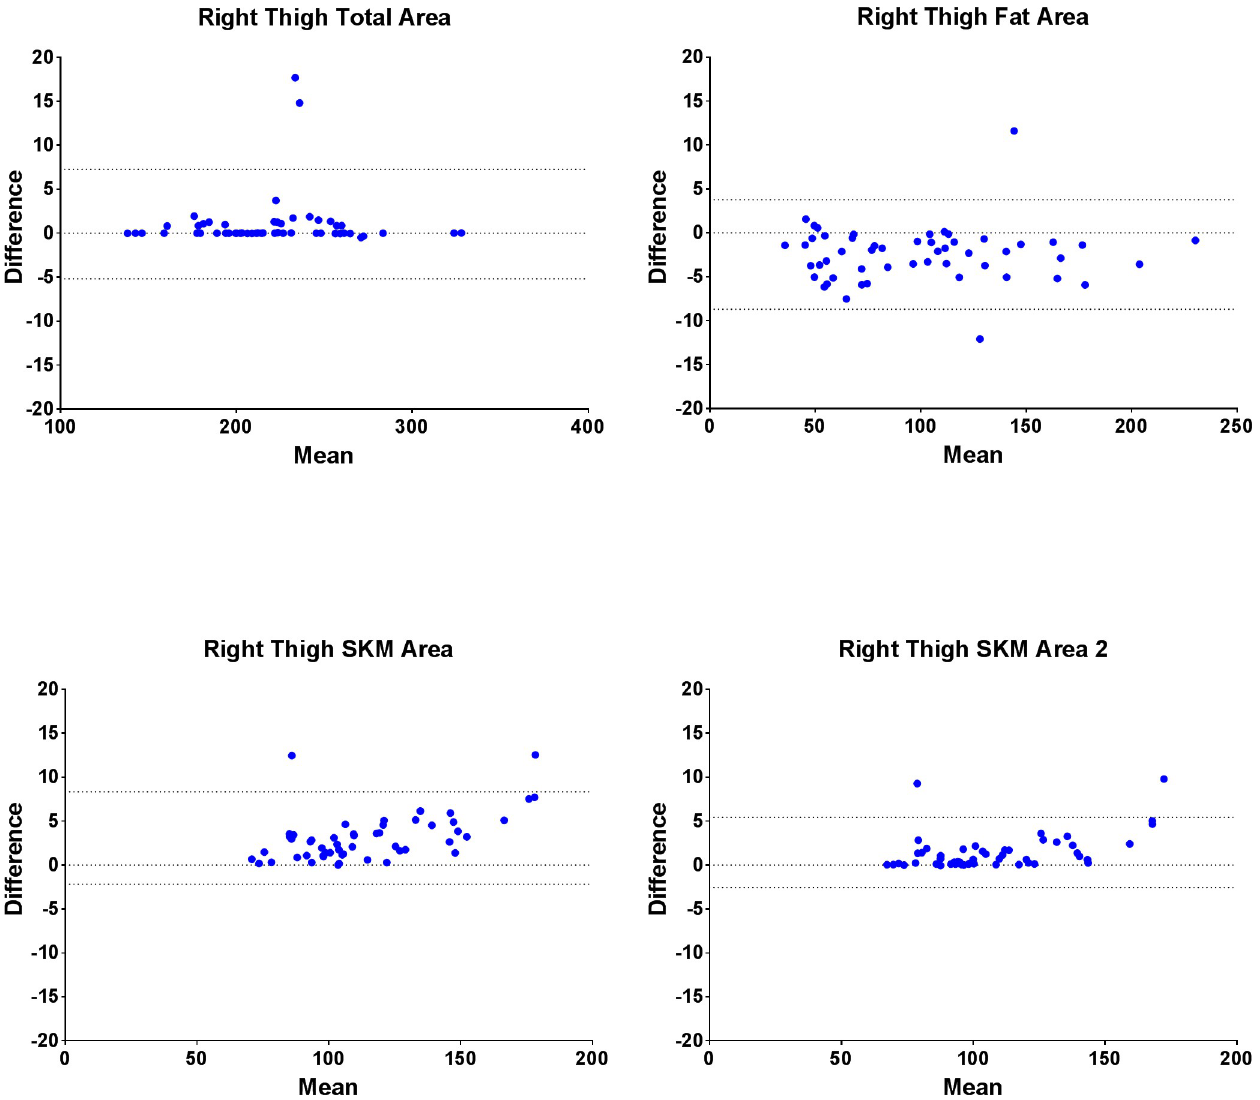
Fig 2. Bland-Altman plots of the individual subject differences between softwares for various cross sectional areas.